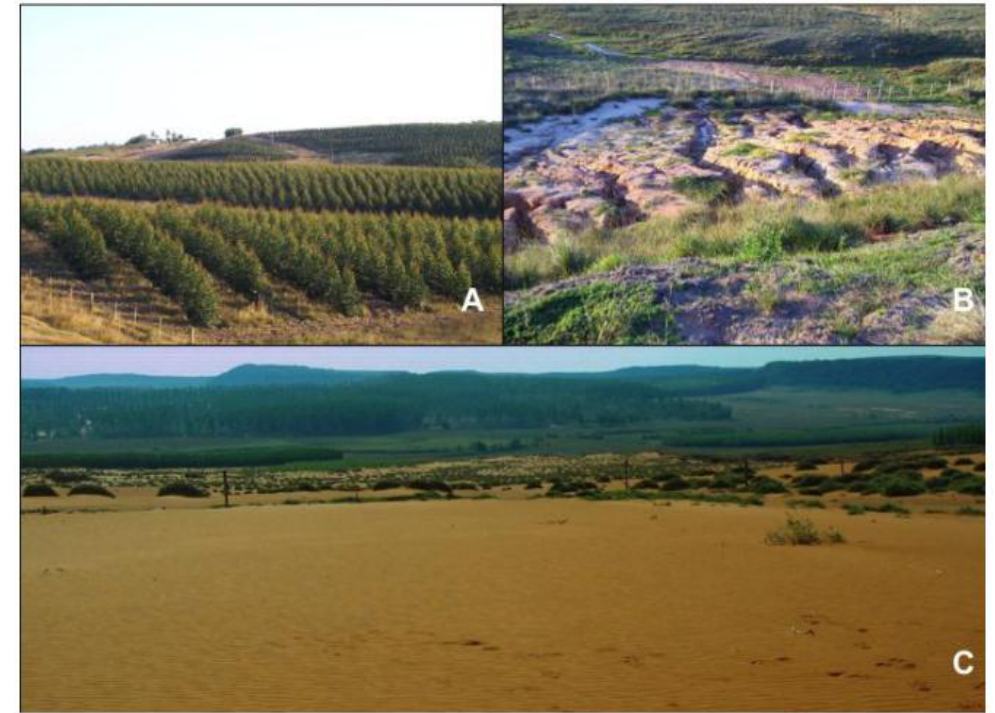
Figure 2 . Specific sites found in the Brazilian Pampa highlighting the conversion of native areas to commercial forest plantations and the fragility of the soils. (a) Commercial forest plantation of exotic tree species ( Eucalyptus sp.). (b) Spots of arenite outcrops, mainly of the Botucatu formation, where extremely sandy soils exhibit damaging losses of clay, silt and organic matter. (c) The result of the ―sandification‖ process (see